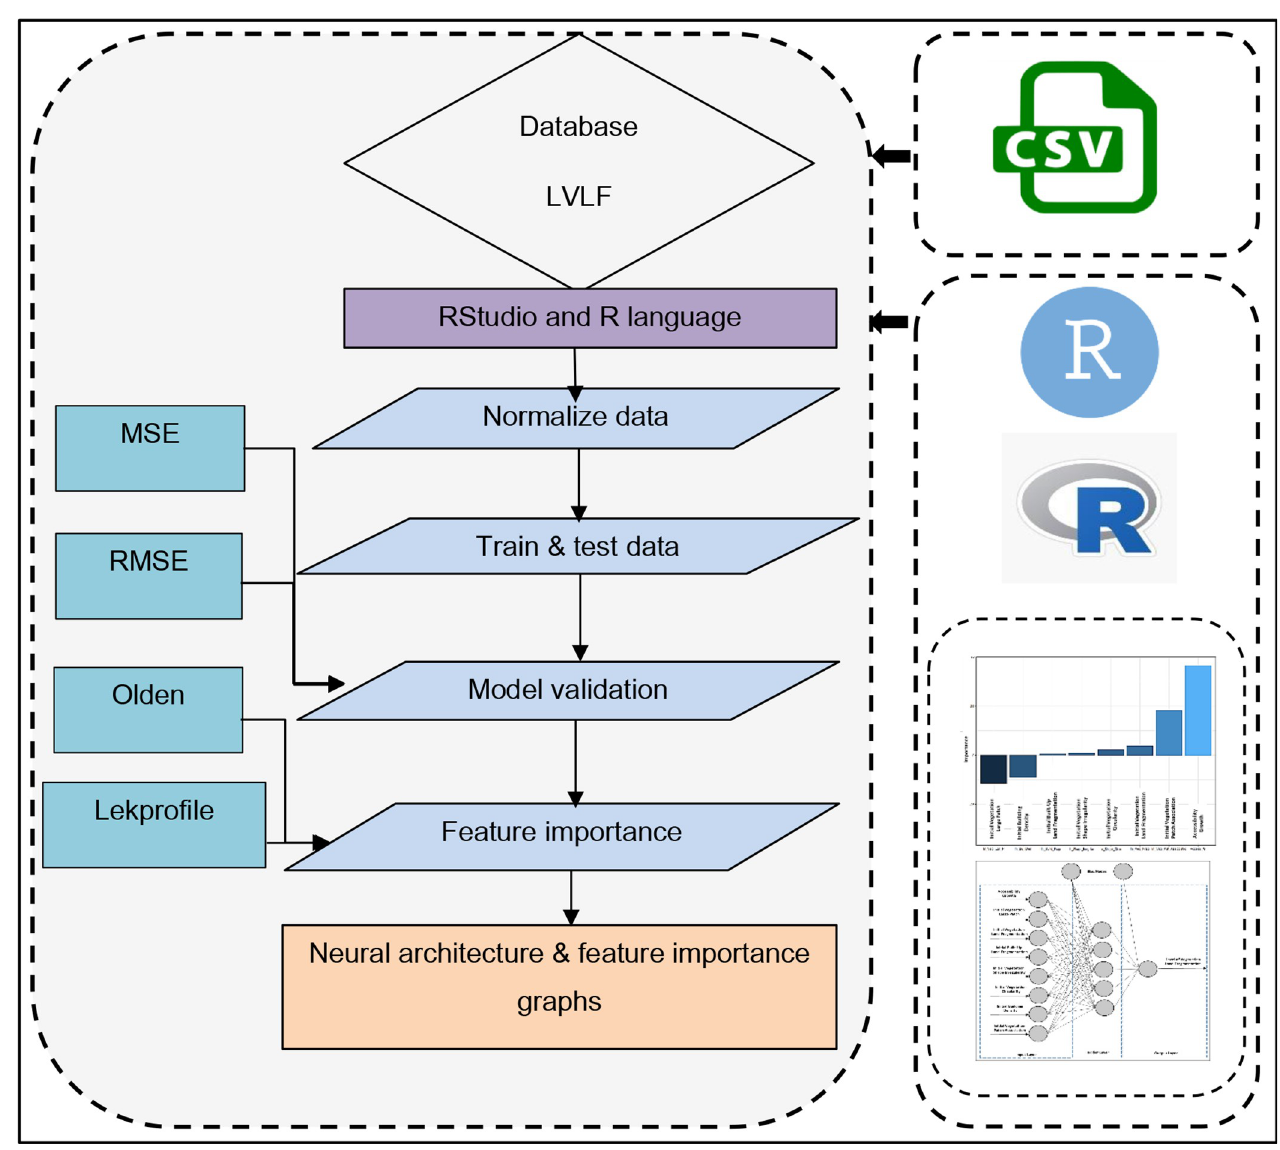
Fig 7. Computation process of